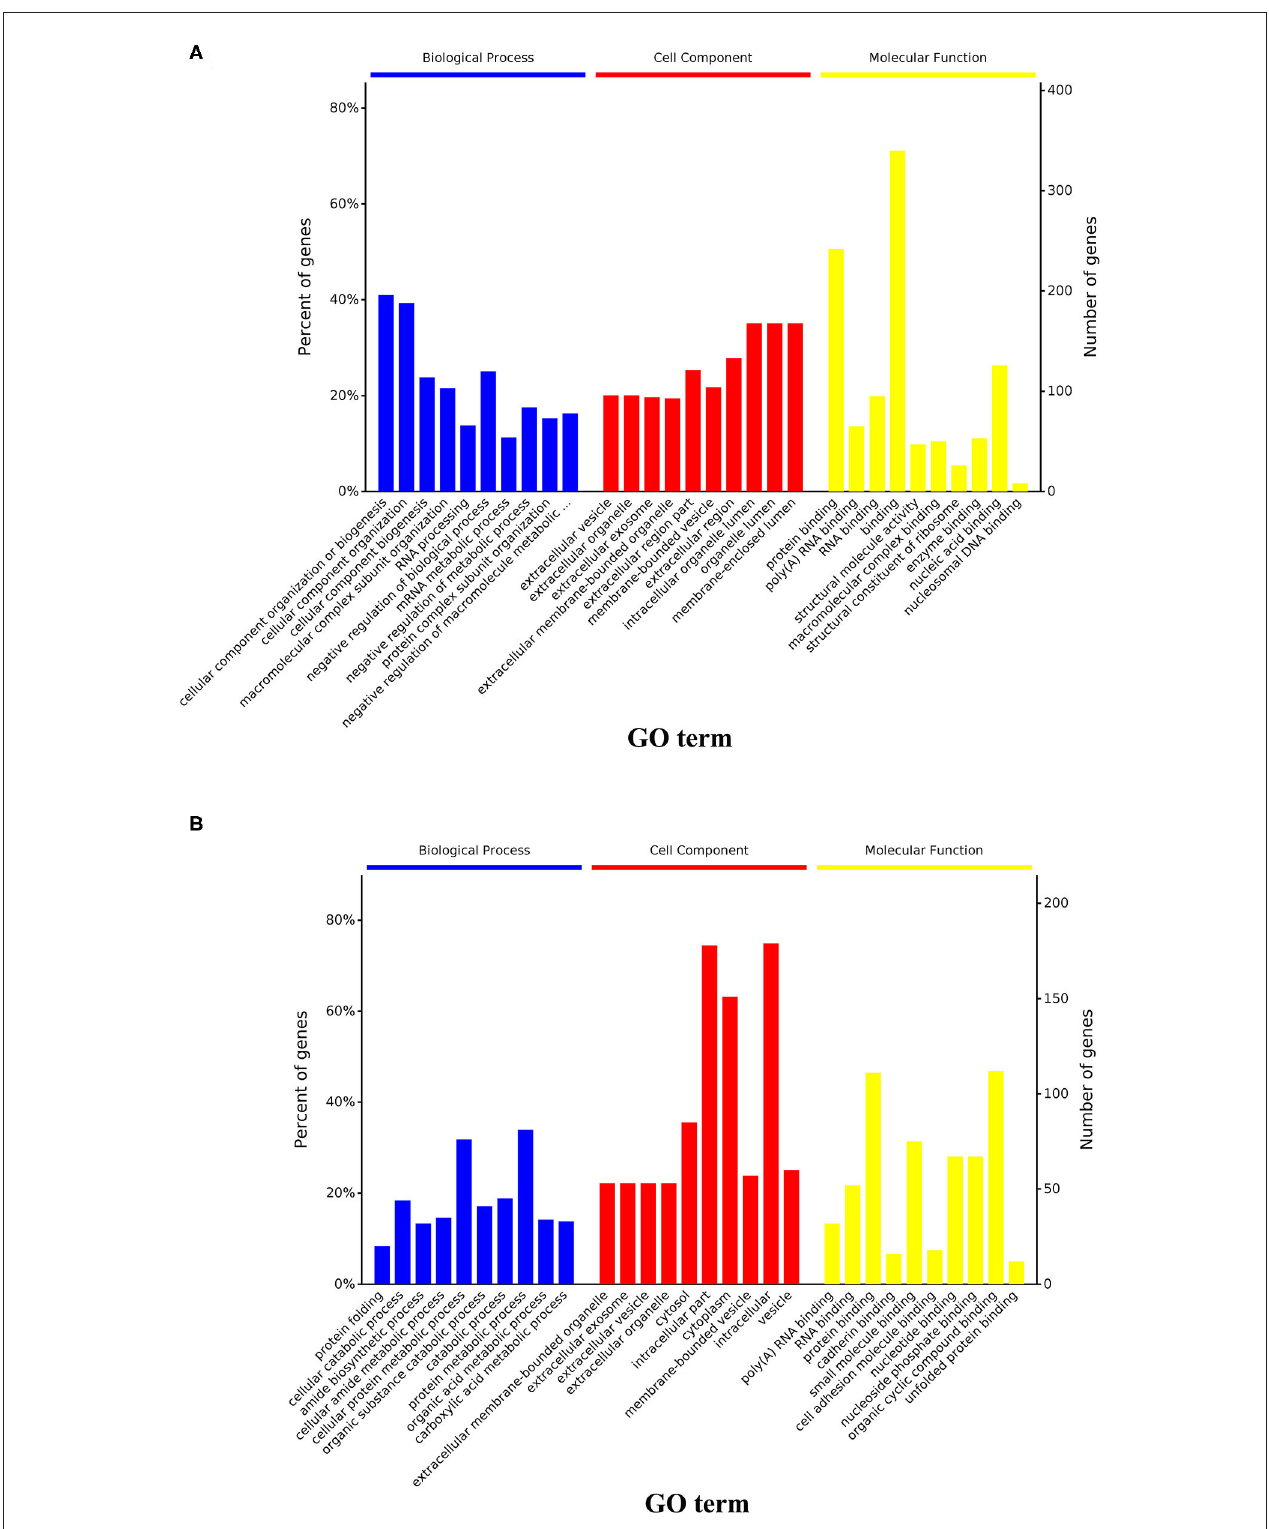
FIGURE 6 | GO and KEGG enrichment analysis of the upregulated and downregulated DAPs. (A) Results of GO analysis of upregulated DAPs in cells from the DUGL group; (B) Results of GO analysis of downregulated DAPs in cells from the DUGL group. DAPs, differentially abundant proteins.